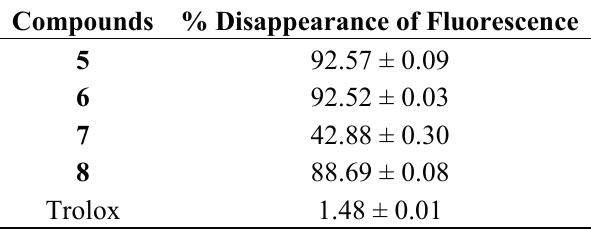
Table 5. Percentage of disappearance of fluorescence in presence of menadione (50 μ